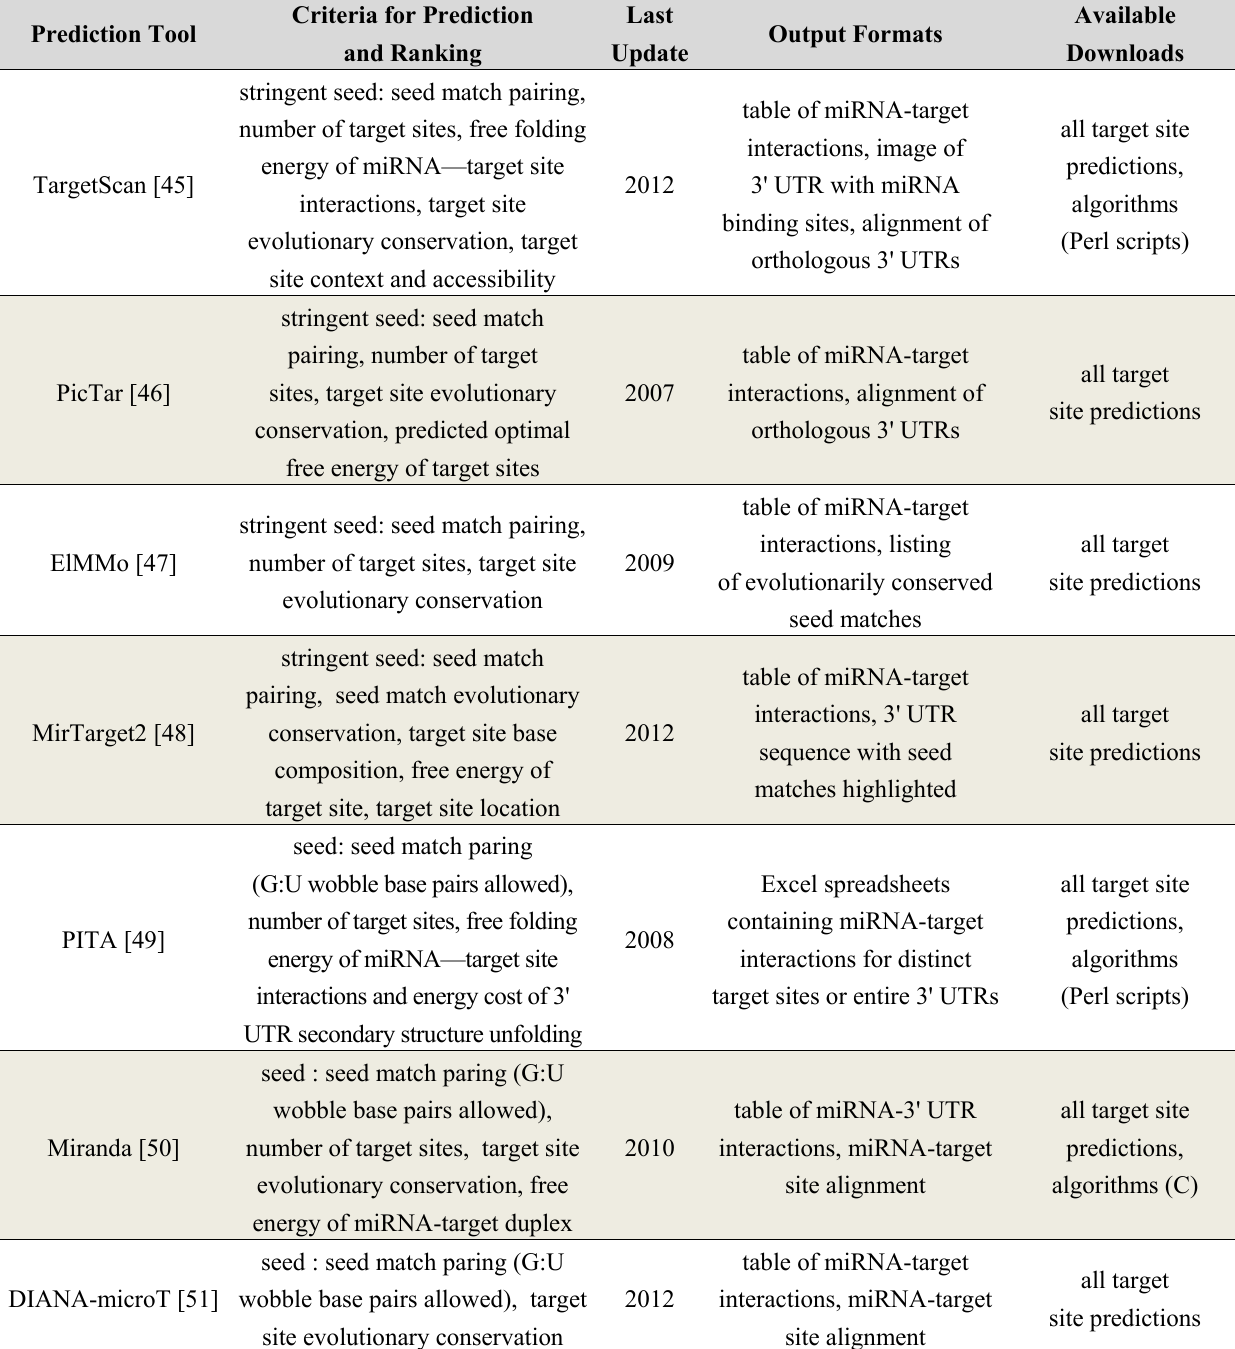
Table 1. MicroRNA target prediction tools.